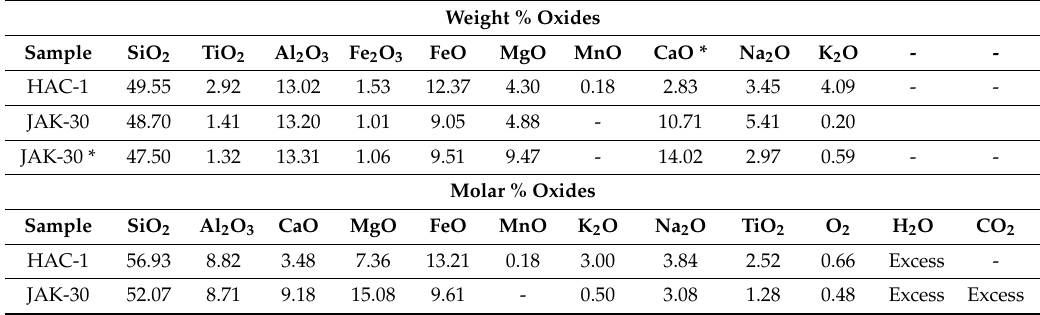
Table 9. Bulk-rockcompositionofHAC-1andJAK-30metabasitesinoxideweightandmolarpercentages. Table 9. Bulk-rock composition of HAC-1 and JAK-30 metabasites in oxide weight and molar percentages.